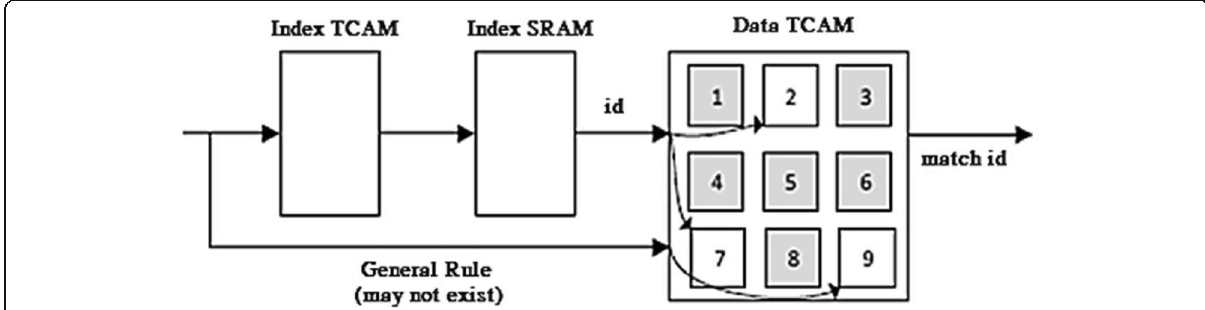
Fig. 3 The architecture of TCAM-based hardware classifier